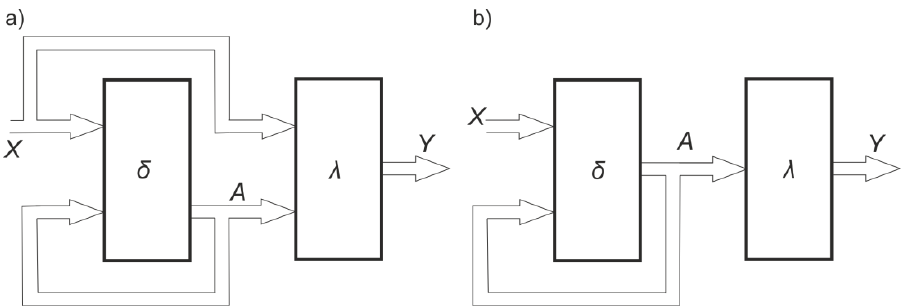
Figure 1. Structure of a sequential machine: ( a ) Mealy, ( b ) Moore.